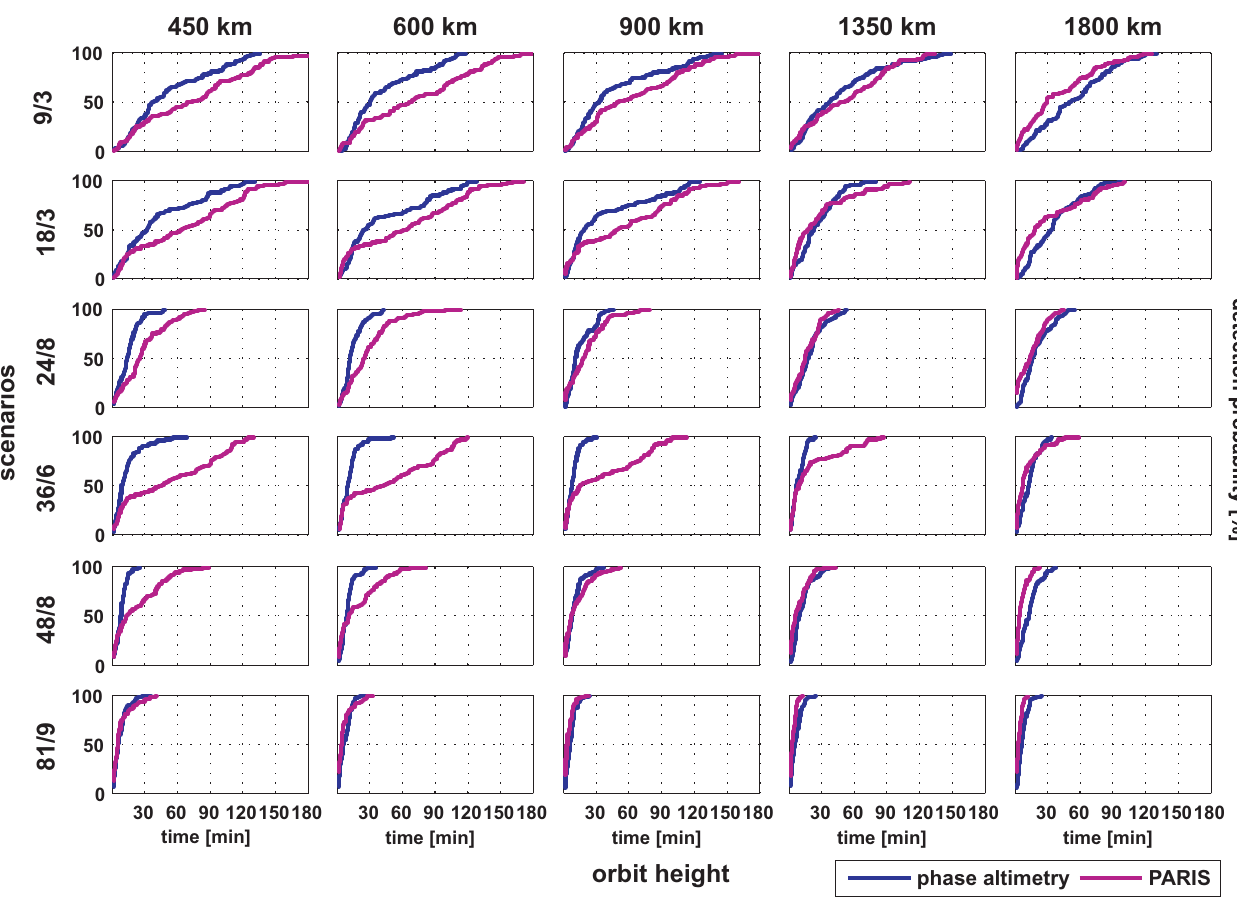
Fig. 12. Sumatra tsunami detection probability plots for six different constellation scenarios with five different orbit altitudes, all at 60 ◦ inclination angle. GPS, GLONASS and Galileo are taken as signal sources and the altimetric sensitivity is assumed to be 20cm. The plots show results for a carrier phase altimetry antenna configuration (fore and aft looking, 120 ◦ full opening angle, elevations < 10 ◦ ) in blue and for a PARIS configuration (downlooking omnidirectional antenna, elevations > 30 ◦ ) in